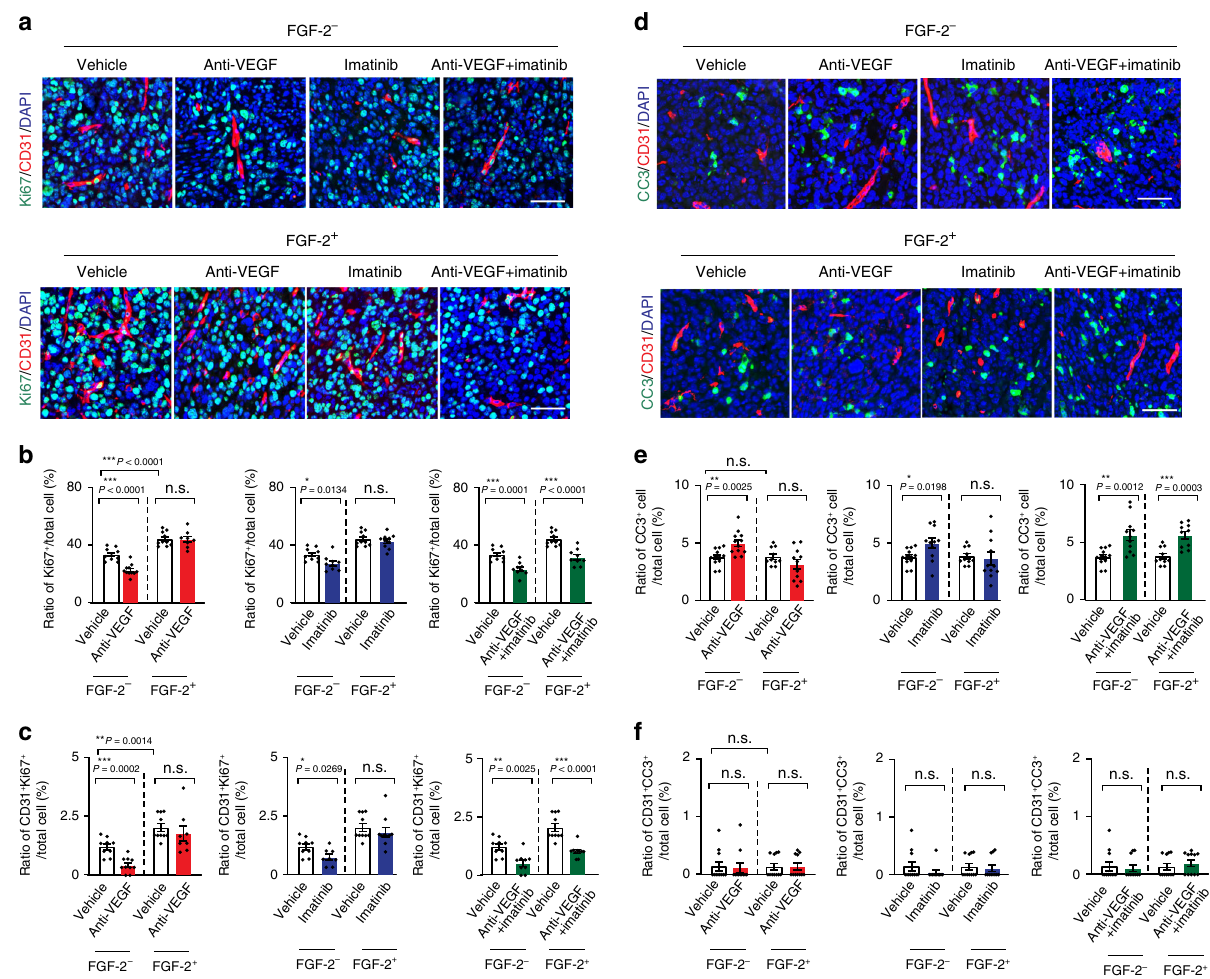
Fig. 5 Tumor cell proliferation and apoptosis of FGF-2 fi brosarcomas in response to various drug treatment. a Ki67 + proliferative cell signals (green) co-stained with CD31 + microvessels (red) and DAPI (blue) of various monotherapy and combination therapy-treated T241-vector and T241-FGF-2 fi brosarcomas. Bar = 50 μ m. b Quanti fi cation of Ki67 + signals in vehicle-, anti-VEGF-, imatinib- and combination therapy-treated T241-vector and T241- FGF-2 fi brosarcomas ( n (Vector) = 10/11/9/9; n(FGF-2) = 10/8/10/9; P (Vector vs FGF-2) < 0.0001; P (Vehicle-treated vector vs anti-VEGF-treated vector) < 0.0001; P (Vehicle-treated vector vs imatinib-treated vector) = 0.0134; P (Vehicle-treated vector vs the combination therapy-treated vector) < 0.0001; P (Vehicle-treated FGF-2 vs the combination therapy-treated FGF-2) < 0.0001). c Quanti fi cation of Ki67 + and CD31 + double-positive signals in vehicle-, anti-VEGF-, imatinib- and combination therapy-treated T241-vector and T241-FGF-2 fi brosarcomas ( n (Vector) = 9/10/8/9; n(FGF-2) = 10/8/ 10/10; P (Vector vs FGF-2) = 0.0014; P (Vehicle-treated vector vs anti-VEGF-treated vector) = 0.0002; P (Vehicle-treated vector vs imatinib-treated vector) = 0.0269; P (Vehicle-treated vector vs combination therapy-treated vector) = 0.0025; P (Vehicle-treated FGF-2 vs combination therapy-treated FGF-2) < 0.0001). d Micrographs of caspase-3 + apoptotic cells (green) co-stained with CD31 + microvessels (red) and DAPI (blue) in various monotherapy- and combination therapy-treated T241-vector and T241-FGF-2 fi brosarcomas. Bar = 50 μ m. e Quanti fi cation of caspase-3 + signals in vehicle-, anti-VEGF-, imatinib- and combination therapy-treated T241-vector and T241-FGF-2 fi brosarcomas ( n (Vector) = = 12/12/11/11; n(Vector) = 10/11/11/10; P (Vehicle-treated vector vs anti-VEGF-treated vector) = 0.0025; P (Vehicle-treated vector vs imatinib-treated vector) = 0.0198; P (Vehicle- treated vector vs combination therapy-treated vector) = 0.0012; P (Vehicle-treated FGF-2 vs combination therapy-treated FGF-2) = 0.0003). f Quanti fi cation of caspase-3 + -CD31 + double-positive signals in vehicle-, anti-VEGF-, imatinib- and combination therapy-treated T241-vector and T241- FGF-2 fi brosarcomas ( n (Vector) = 11 each; n(Vector) = 11 each). FGF-2 - = vector cancers; FGF-2 + = FGF-2 cancers; n.s. Not signi fi cant; * P < 0.05; ** P < 0.01; *** P < 0.001; two-tailed t -test. Data presented as mean ± s.e.m. Experiments were independently repeated twice. Source data are provided as a Source Data fi